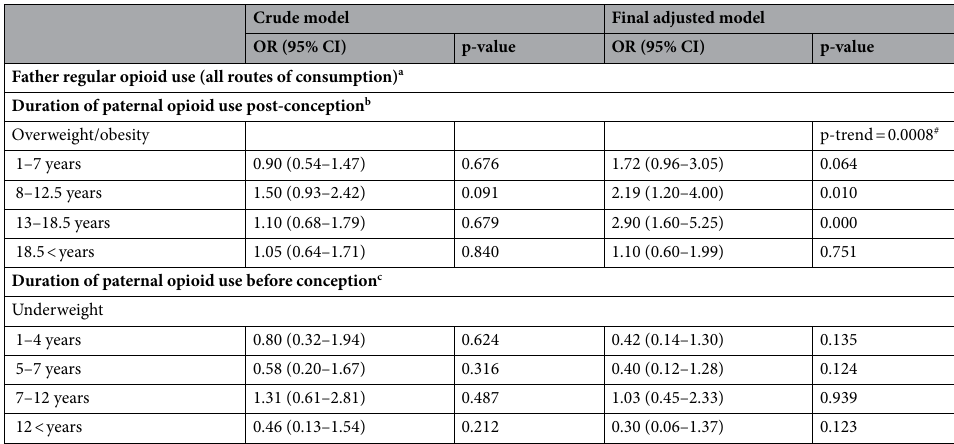
Table 4. Estimated crude and adjusted odds ratios for the overweight/obesity and underweight, as predicted by duration of paternal exposure to opioid. OR odds ratio, CI confidence interval, BMI: body mass index. a,b,c Adjusted for age, sex, father and mother, BMI, paternal smoking, and father and mother education years. *Underweight: BMI < 18. **Overweight/obesity: BMI > 25. # pTrend of linear correlation is estimated for values of duration of paternal opioid use post-conception which are lower than 19